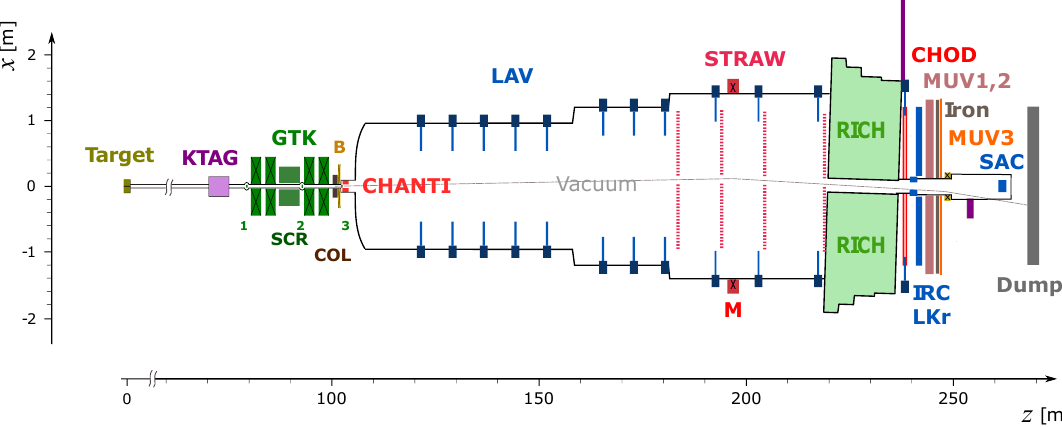
Figure 1 . Schematic top view of the NA62 beamline and detector. The “CHOD” label indicates both the CHOD and NA48-CHOD hodoscopes described in the text. Also shown is the trajectory of a beam particle in vacuum which crosses all the detector apertures, thus avoiding interactions with material. A dipole magnet between MUV3 and SAC deflects the beam particles out of the SAC